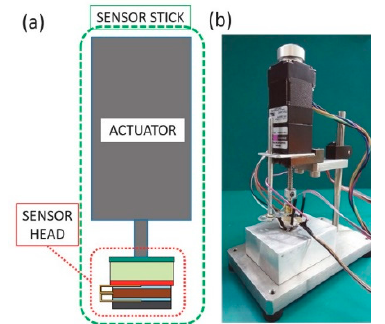
Figure 5. ( a ) Structure model of sensor stick; ( b ) Phtograph of sensor stick.